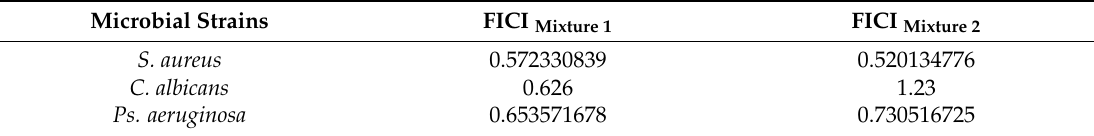
Table 2. Fractional inhibitory concentration index (FICI) values calculated for the tested strains/mixture.